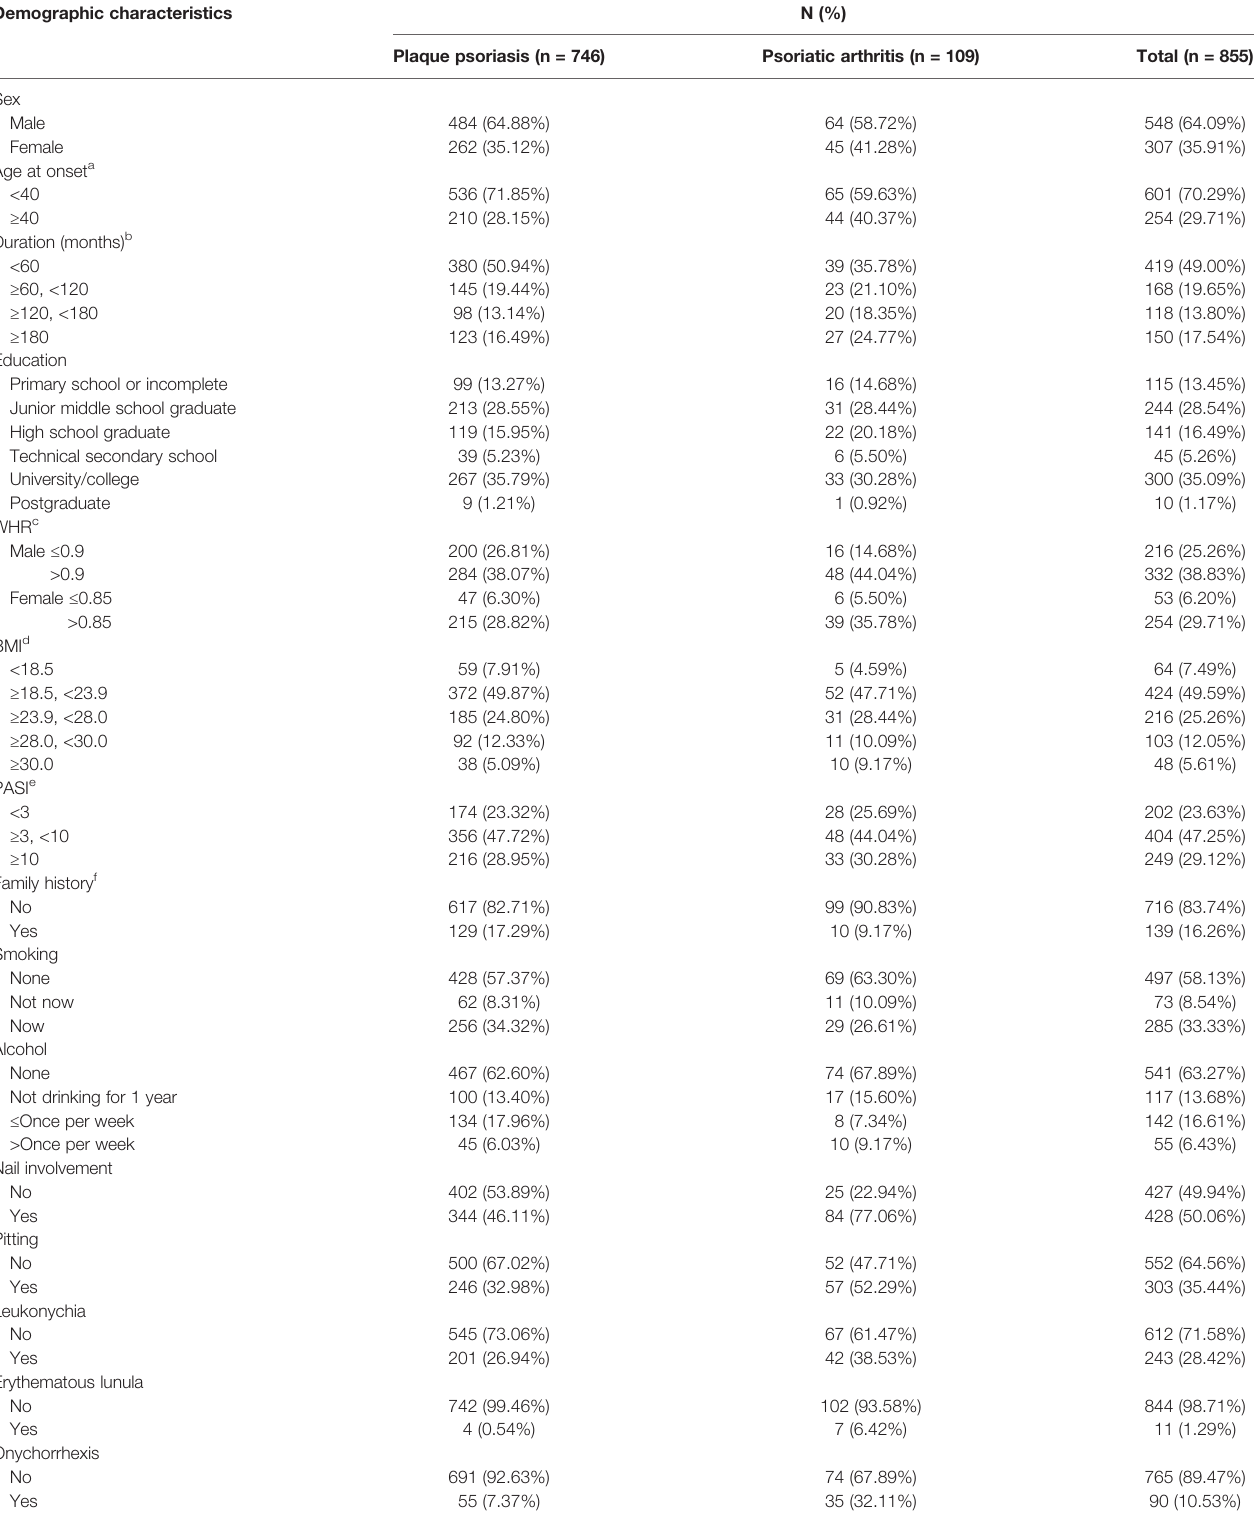
TABLE 1 | Differences between demographic and clinical characteristics of plaque psoriasis and psoriatic arthritis